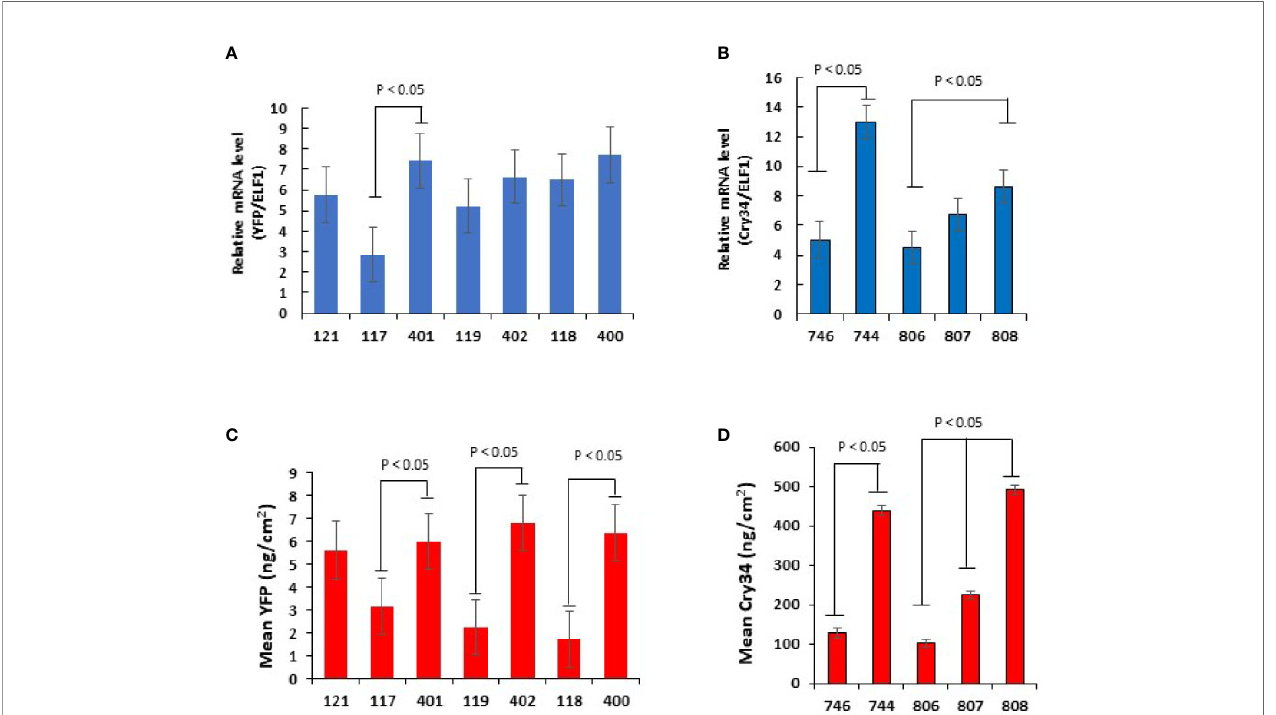
FIGURE 2 | Transgene expression analysis of mRNA and protein in T 1 plants containing the yfp and cry34Ab1 reporter genes. qRT – PCR analysis of yfp (A) and cry34Ab1 (B) for relative mRNA transcript levels in V6 leaves of transgenic maize plants. The same plants were used to quantitate protein accumulation for yfp (C) and cry34Ab1 (D) . All plants were derived from the hemizygous T 1 plants of distinct transgenic events. For each construct, the data points were collected from three to fi ve independent transgenic events (lines) and minimum 10 sibling plants per event at V6. Data are represented as mean ± SD of the combined data points for each construct, and differences were analyzed with Student ’ s t-test. The comparison showing a signi fi cant difference is indicated (p<0.05). The negative control construct (121 and 746) transgenic plants when used with Figure 1B and Figure 1A group of transgenic plants, respectively, did not show any mRNA or protein